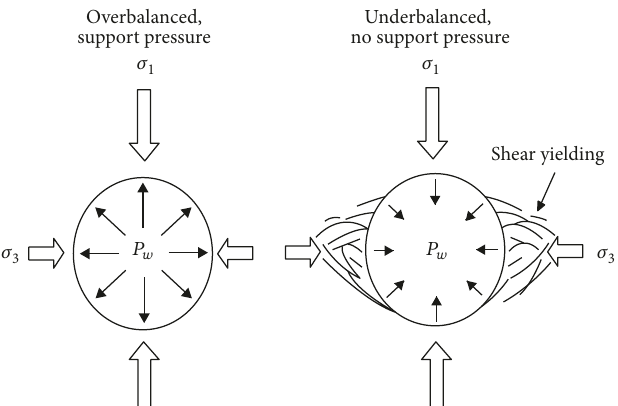
Figure 10: Shear yielding occurs for underbalanced conditions due to the absence of a support pressure on the borehole wall [16].